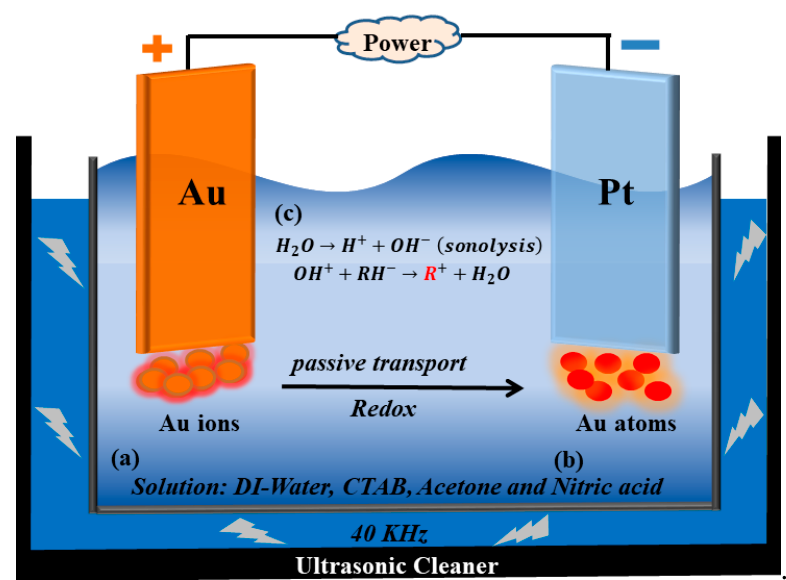
Figure 1. Schematic diagrams for gold nanoparticles (GNPs) via electrochemistry preparation: ( a ) the preparation of grown solution; ( b ) HNO 3 added as a catalyst, forming a micelle template of condensation reaction; ( c ) electrolysis and oscillation are kept working in the interim.